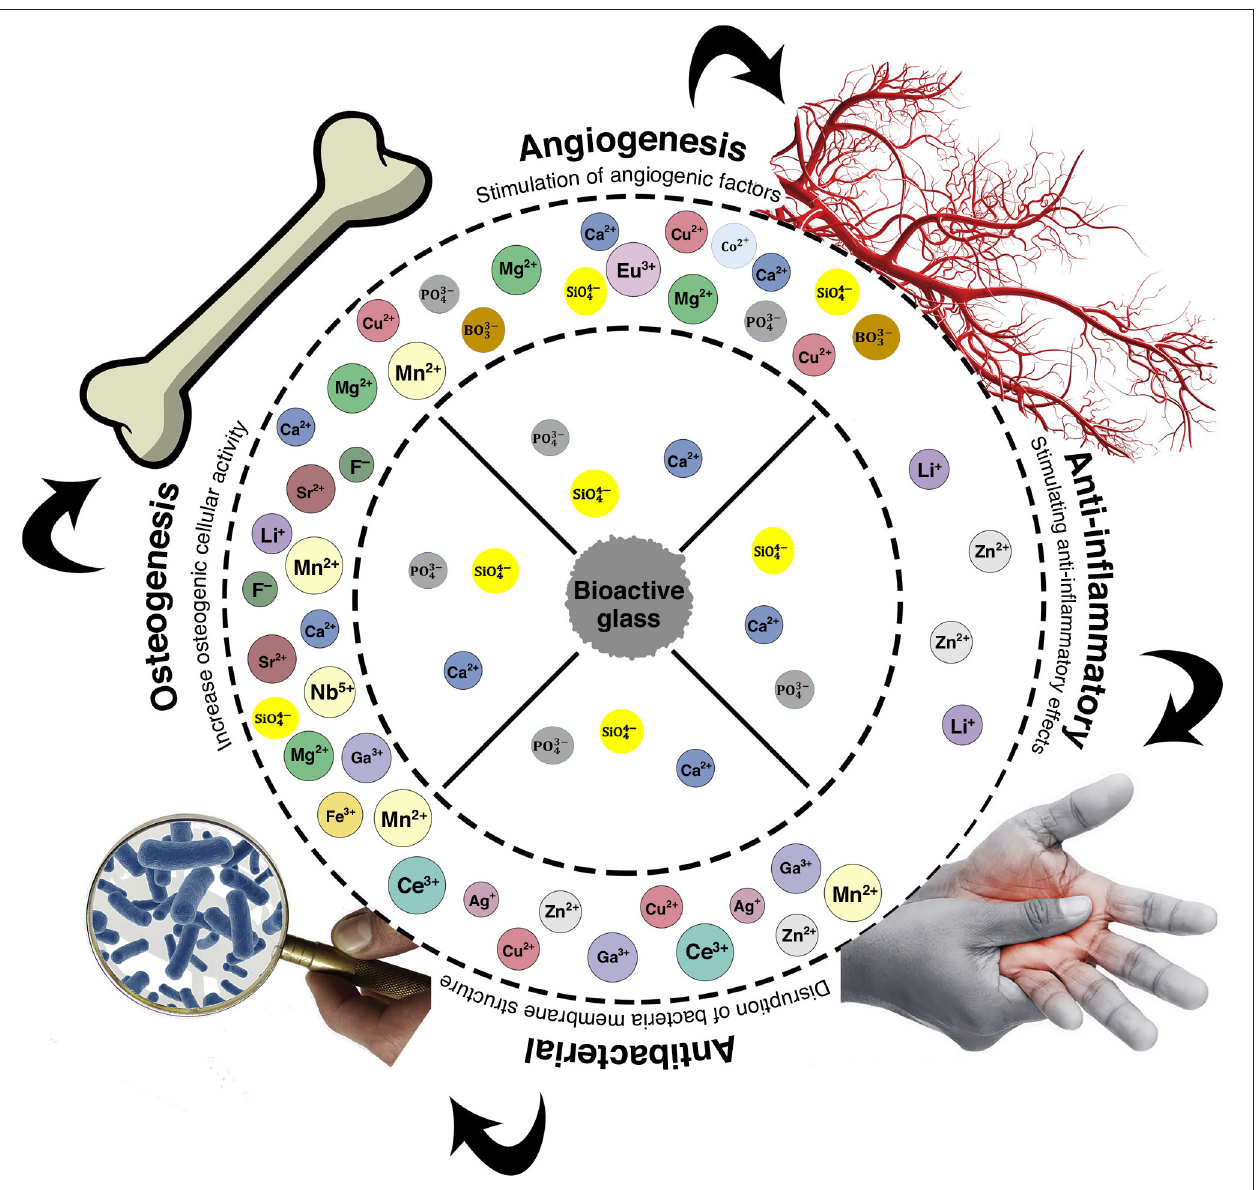
FIGURE 2 | The biological effects of BGs are related to the release of therapeutic ions from their structure into the surrounding environment. Reproduced with some modifications from Kargozar et al.